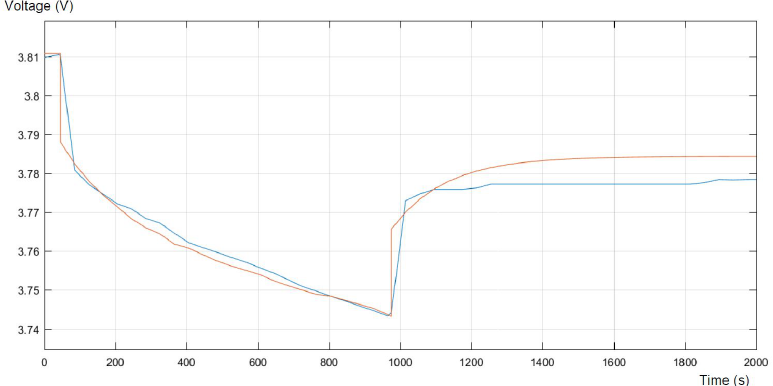
Figure 8. Comparison between the model and NMC1 during pulse discharge tests. The blue curve is the real pulse discharge process measured on the workstation. The red curve presents the model response in the same